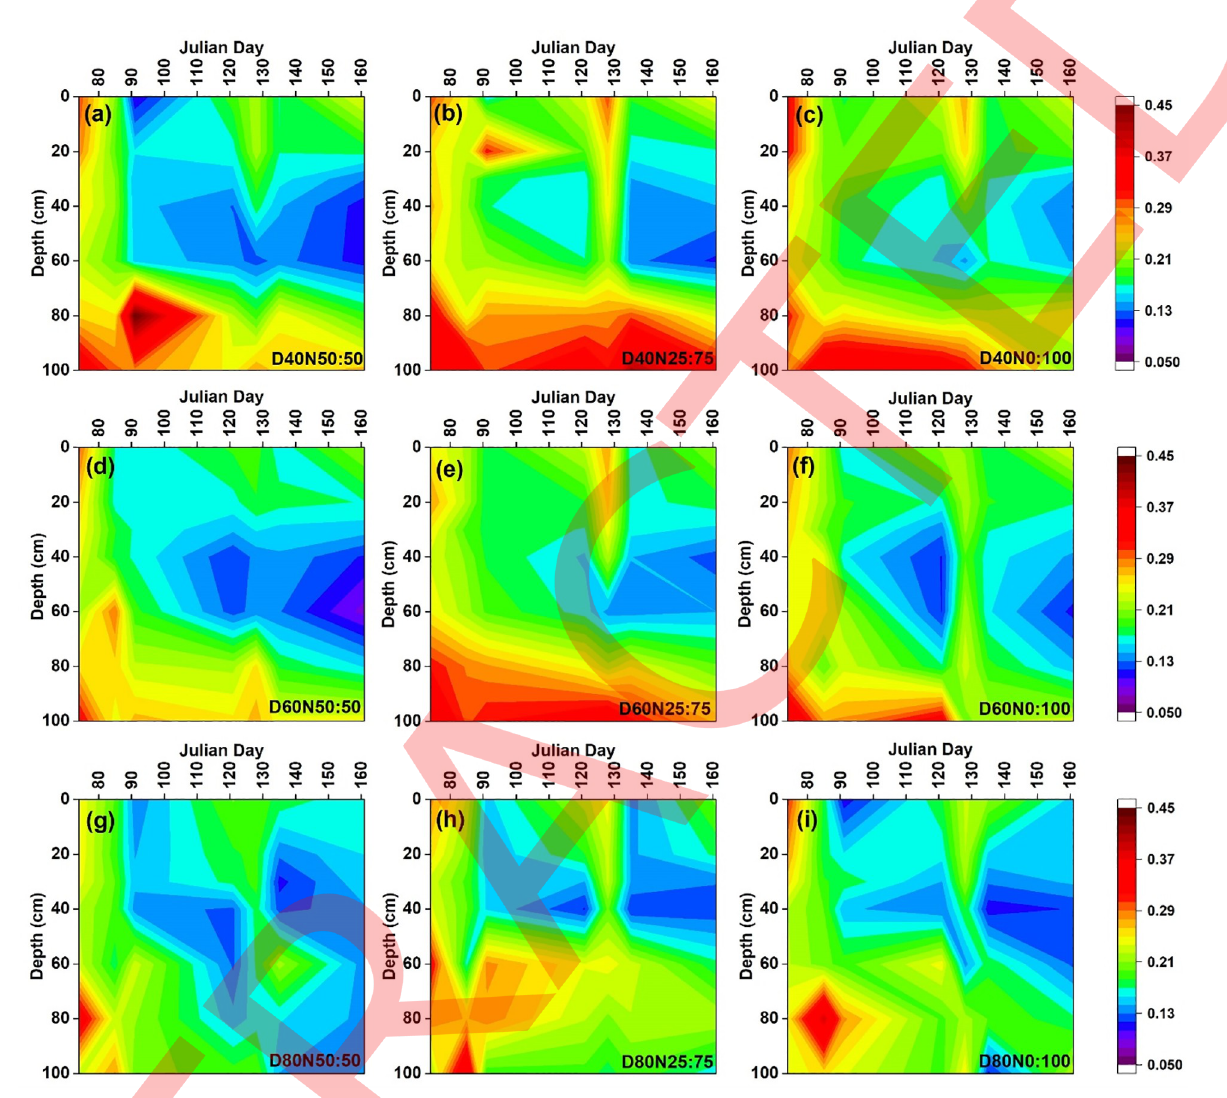
Fig 3. Soil moisture (m 3 /m 3 ) of various LS and NAMs treatments during the 2019 wheat growing